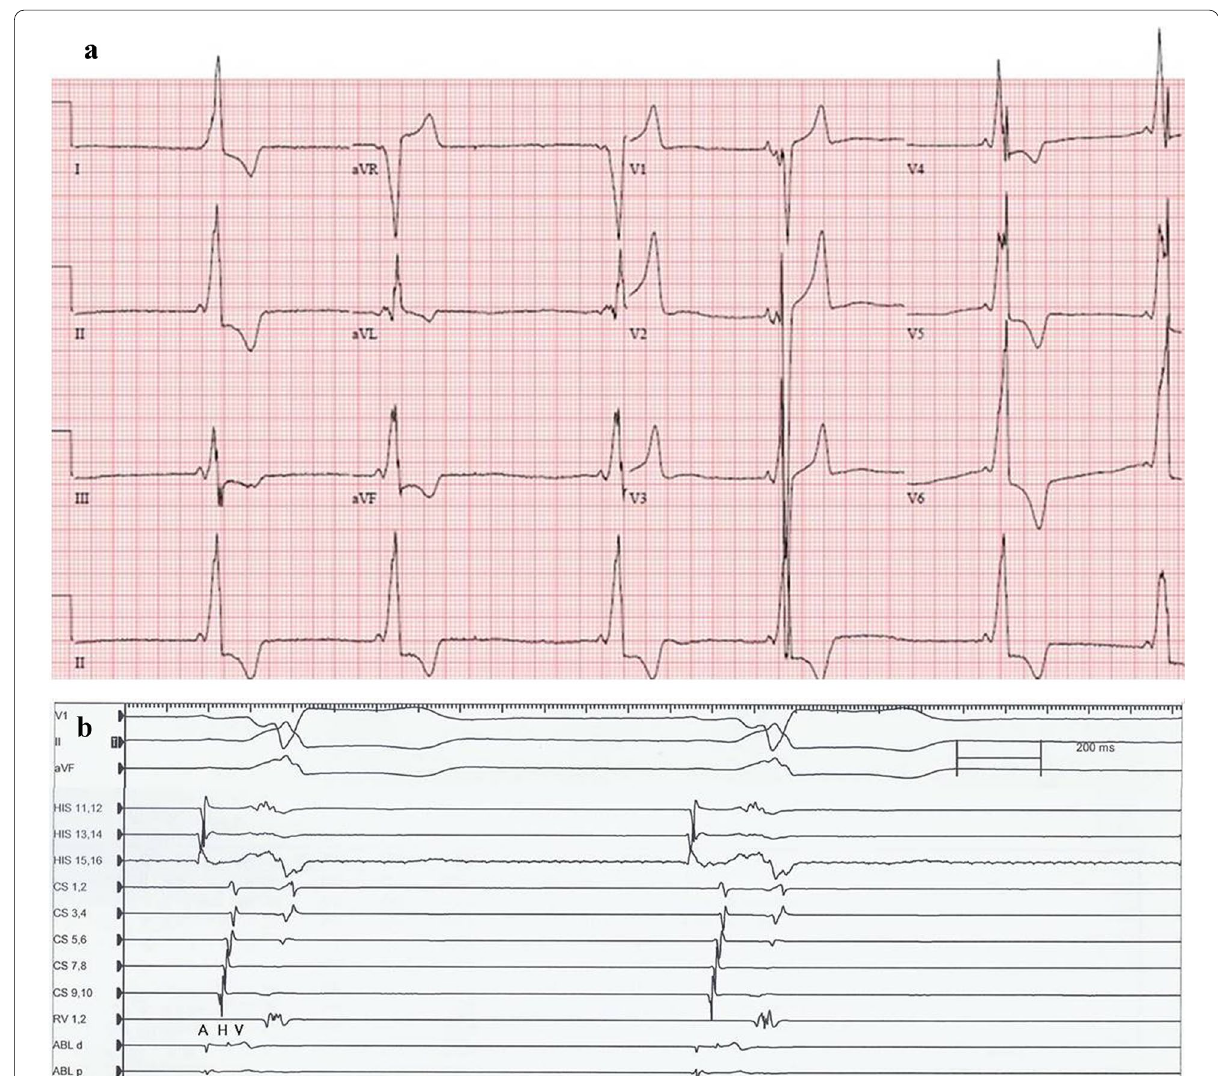
Fig. 2 a After DC cardioversion, marked sinus bradycardia with short PR interval (86 ms) and delta wave was observed. The QRS axis and morphology was not changed. b The ablation catheter was positioned on the His bundle (red dot in Fig. 3). Baseline AH interval was 53 ms and HV interval was 35 ms. A: atrium, ABL: ablation catheter (d: distal, p: proximal), CS: coronary sinus (9, 10: proximal site, 1, 2: distal site), H and HIS: His bundle, RV: right ventricle, V: